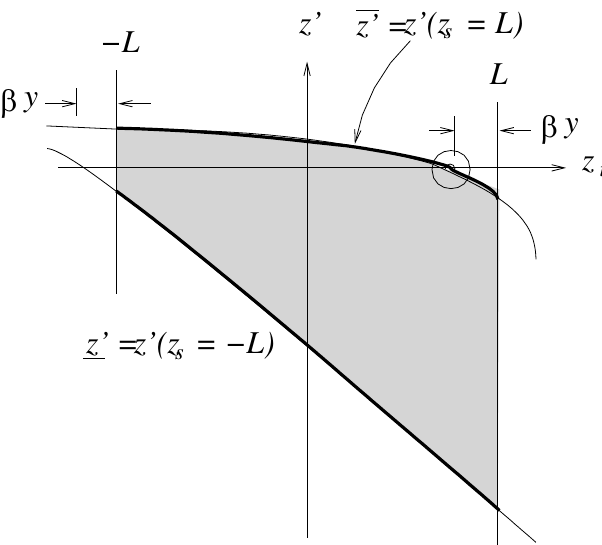
FIG. 4. The region of effective charge contributing to the the uniform charge total bunch self-force. At given test point z t (cid:1) (cid:4) L; y (cid:3) to z 0 (cid:1) z 0 (cid:2) z (cid:1) distribution runs from z 0 (cid:1) z 0 (cid:2) z s s (cid:4) L; y (cid:3) . The open circle indicate a troublesome point at which for y ! there is a ‘‘one-sided’’singularity in the integral over z t 0 .